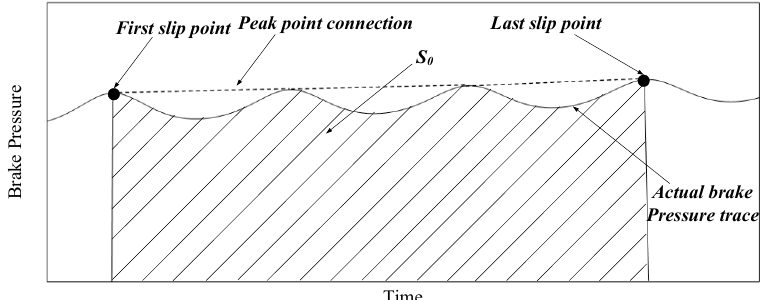
Figure 6. Brake efficiency scheme.